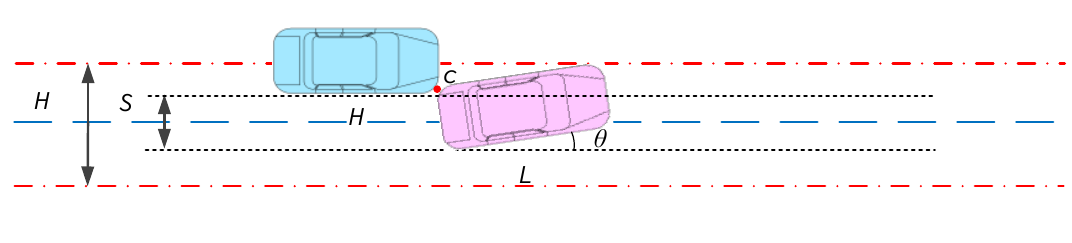
Figure 15. The position of cut-in vehicle L and host vehicle H.